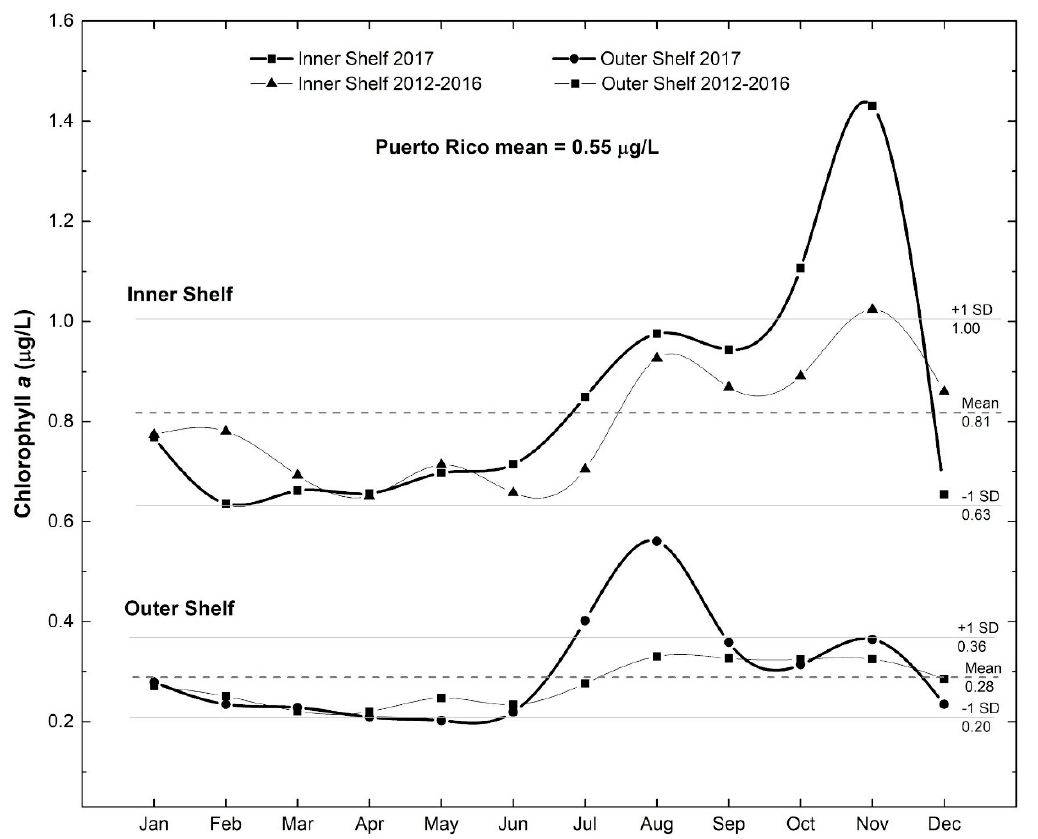
Figure 9. Chlorophyll- a concentration for inner shelf and outer shelf of Puerto Rico waters.